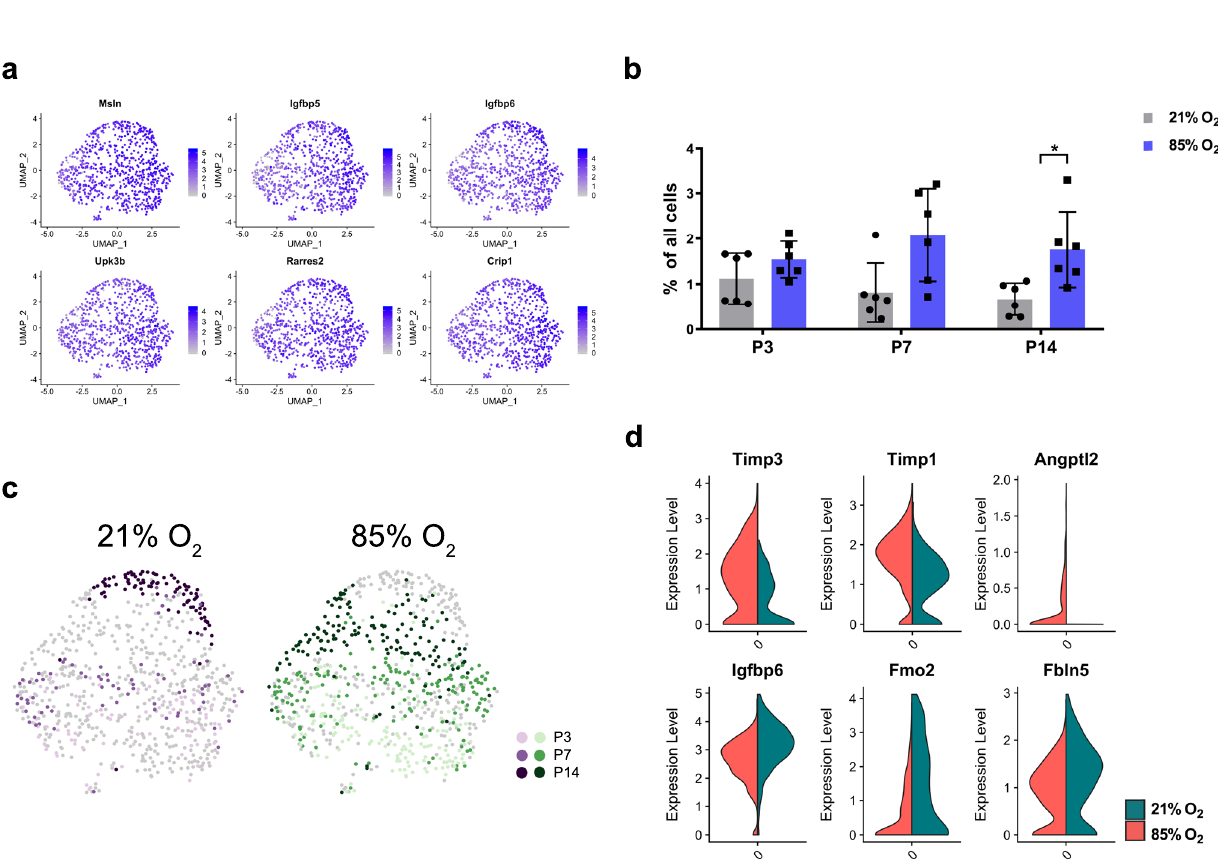
Fig. 7 Cellular composition of lung lymphoid populations during normal and hyperoxia-impaired late lung development. a A total of nine clusters of lymphoid cells were identi fi ed in developing lungs. Cell populations are colored as indicated by the legend. b UMAP plots of principal identi fi ers of identi fi ed types of lymphoid cells The intensity of expression is indicated by purple coloring. c Heatmap of top fi ve most differentially expressed genes across the lymphoid clusters. The intensity of expression is indicated as speci fi ed by the color legend. d Relative contribution of individual lymphoid clusters changed signi fi cantly during development and exposure to hyperoxia. n = 6 animals/group. Cell populations are colored as indicated by the legend. e UMAP plots depicting cell identity in regard to developmental time points in (21% O 2 -exposed, purple) normally and aberrantly (85% O 2 -exposed, green) developing lymphoid populations. Each cell is colored by mouse age as indicated by the legend. f Hyperoxia-impacted signaling pathways in B cells (pink) and CD8 + T cells (bright green) clusters as identi fi ed by gene set enrichment analysis (GSEA). All terms are signi fi cantly enriched (adjusted p value < 0.05) and normalized enrichment scores (NES) are shown. NES values were computed by gene set enrichment analysis on fold change-ranked genes. Expression values in Heatmap represent Z -score-transformed log(TP10k + 1) values. Expression levels in UMAP plots are presented as log(TP10k + 1) values. Log (TP10k + 1) corresponds to log-transformed UMIs per 10k.